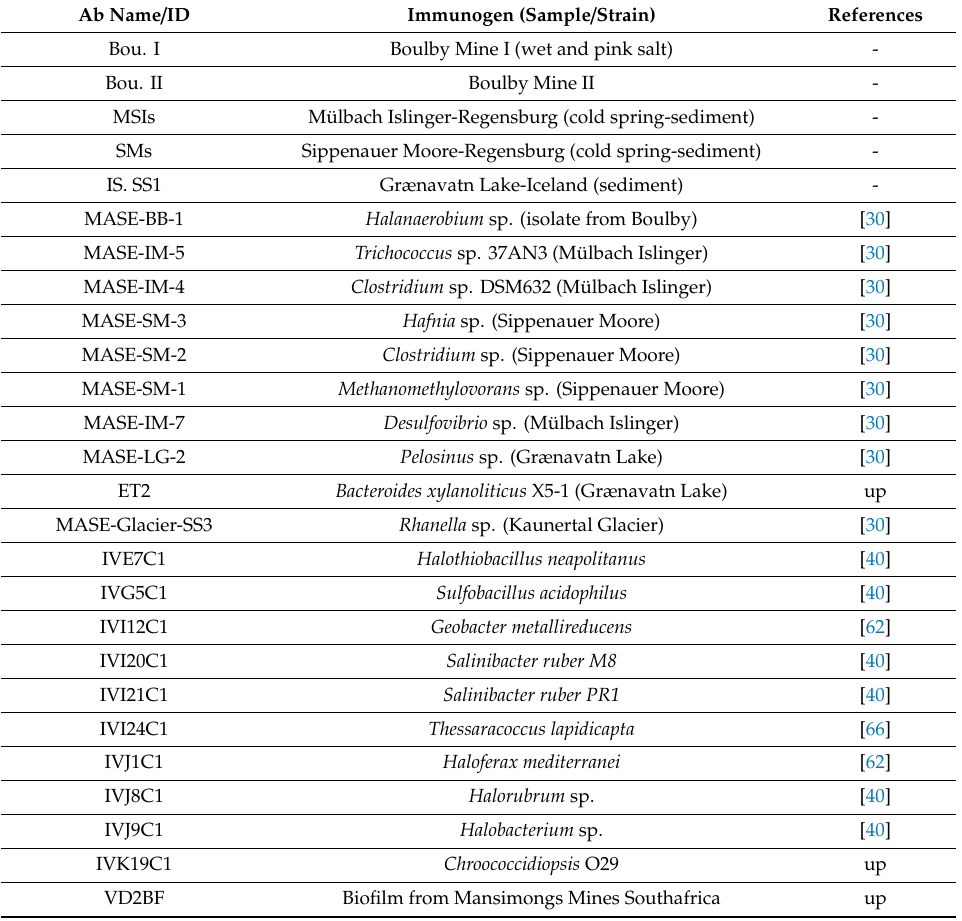
Table 1. Antibodies printed in the MASE-Chip with their IDs (left column), their immunogen source, and their references (up: Unpublished). The first 15 of them came from isolates of MASE project and the rest belong to the Molecular Ecology Laboratory antibody collection at